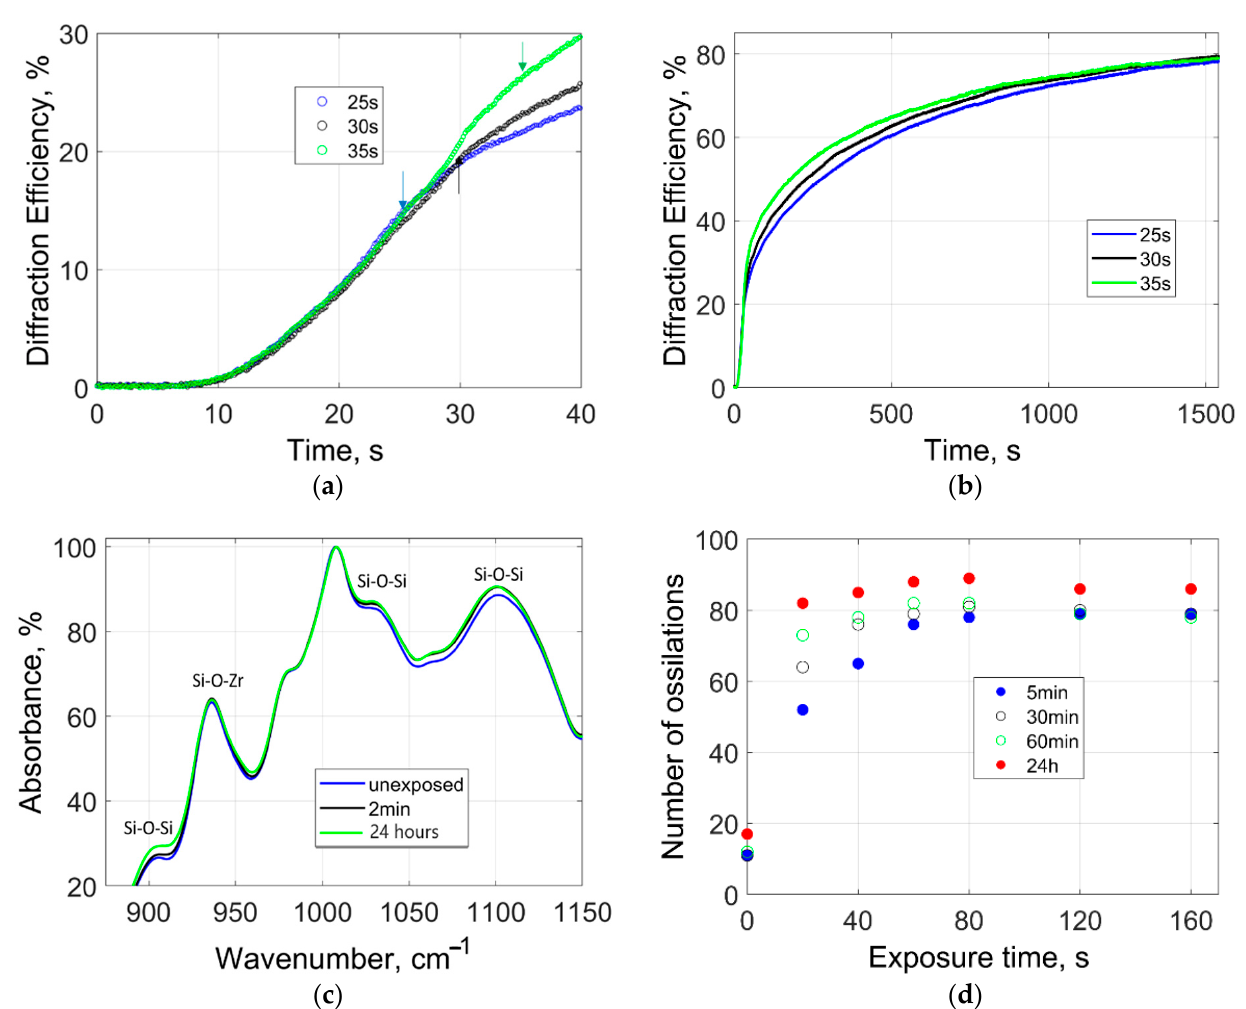
Figure 4. ( a ) Real time diffraction efficiency growth curves of transmission gratings monitored during holographic exposure for 25, 30, and 35 s; arrows show the end of laser exposure; ( b ) diffraction efficiency growth curves of samples shown in Figure 4a monitored during both holographic recording and dark process for 25 min; ( c ) FTIR spectra of PHSG layers measured before exposure to 532 nm uniform beam and 2 min and 24 h after exposure (during dark process); ( d ) hardness test results (number of oscillations) for layers exposed to uniform beam for 20 to 160 s show that within 24 h the layers reach similar